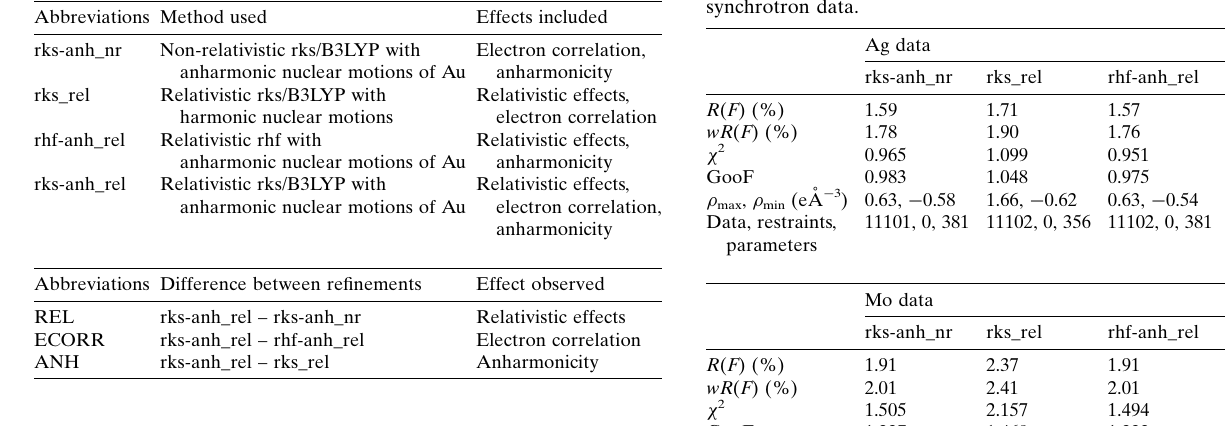
Table 2 Abbreviations of performed refinements.